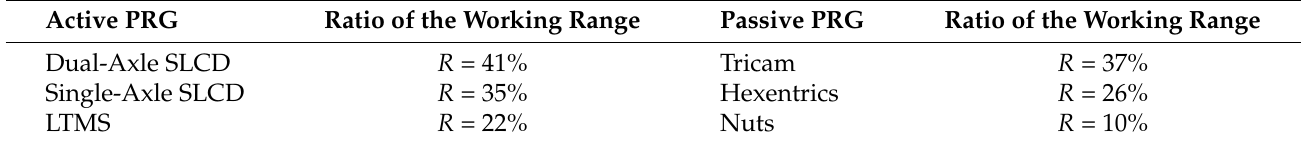
Table 1. Mean value of the individual ratios of working range for selected types of PRG. Active PRG Ratio of the Working Range Passive PRG Dual-Axle